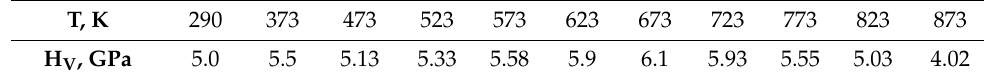
Table 5. Dependence of the microhardness of the Cu-13.5Al-3.5Ni on the temperature of annealing for 30 min after quenching and HPT of n = 10 revs.